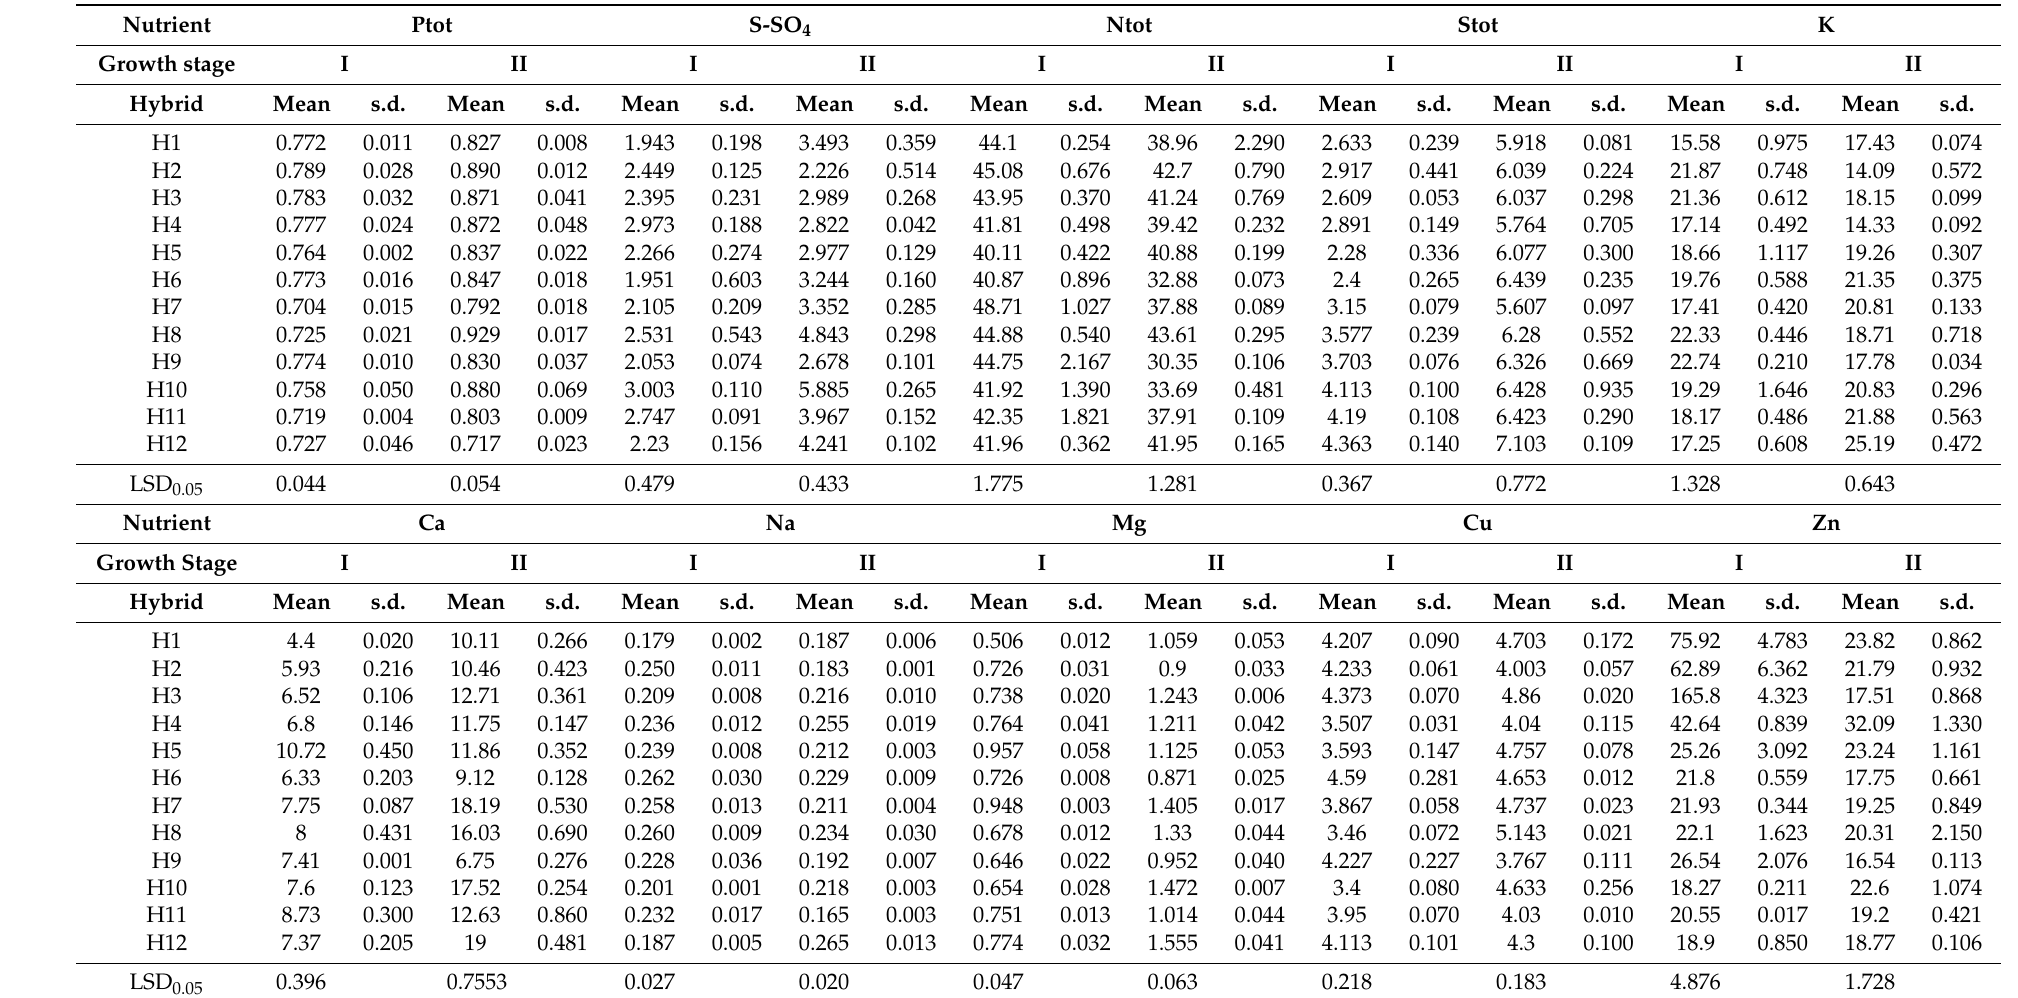
Table 3. Mean values and standard deviations (s.d.) for observed nutrients (N =